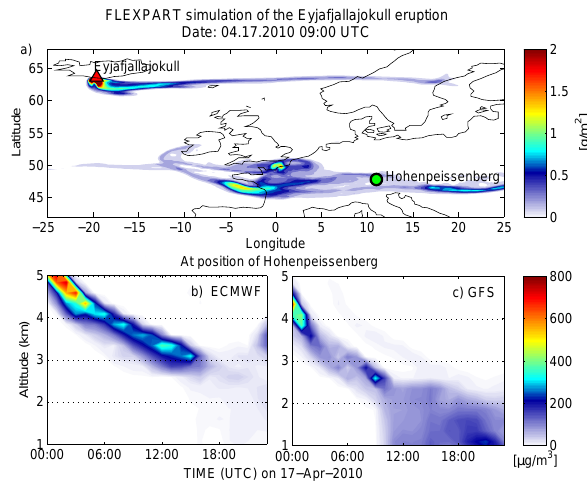
Fig. A8. FLEXPART simulated ash cloud, for comparison with pub- lished lidar observations. (a) FLEXPART a posteriori simulation (running on ECMWF data) of total ash column load, (b) and (c) simulated vertical distribution of ash, using ECMWF and GFS data respectively, over Hohenpeissenberg (47.8 ◦ N, 11.0 ◦ E) on 17 April, to be compared with lidar observations (Fig. 2 of Flentje al.,